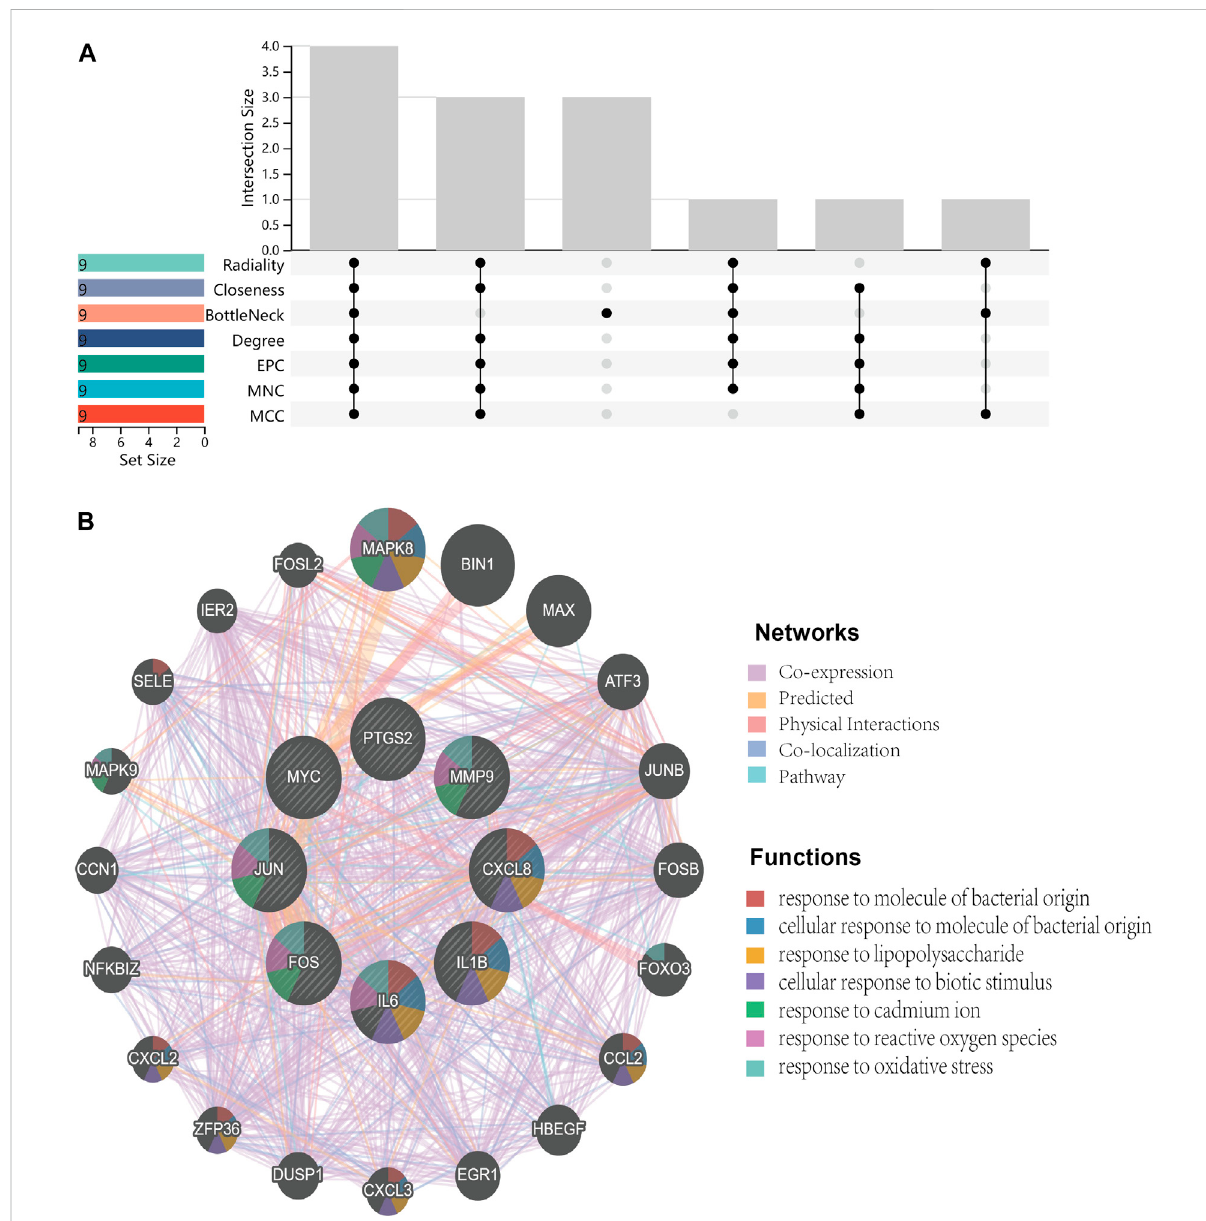
different color blocks inside the circles and the functions are represented by various line